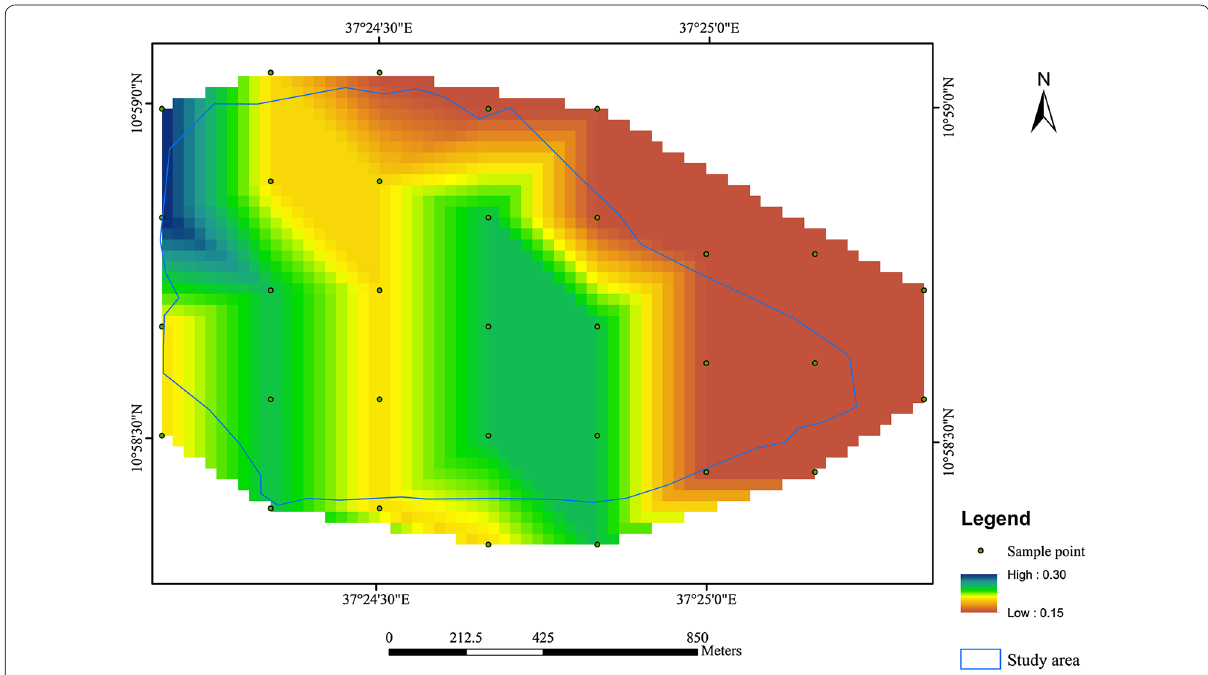
Fig. 1 Erodibility map of the study area